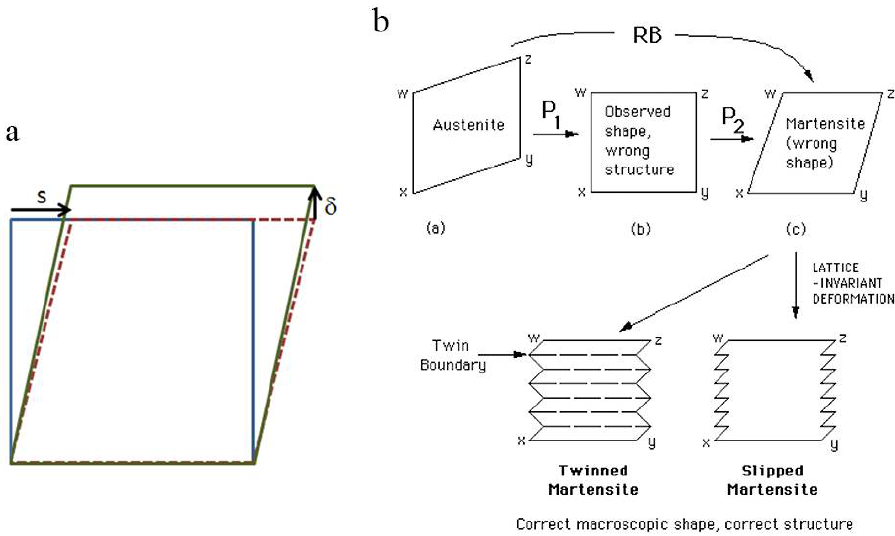
Figure 5. The use of shears in the phenomenological theory of martensitic transformations (PTMC). ( a ) Schematic view of an invariant plane strain (IPS), with the shear value s and the dilatation part δ perpendicularly to the shear plane; ( b ) combination of the IPS P 1 (also called shape strain) with a simple shear P 2 that generates the correct and well-oriented lattice RB . The simple shear P 2 is compensated by a lattice invariant shear to get the correct shape P 1 . Reprinted from [39] with permission from Elsevier.